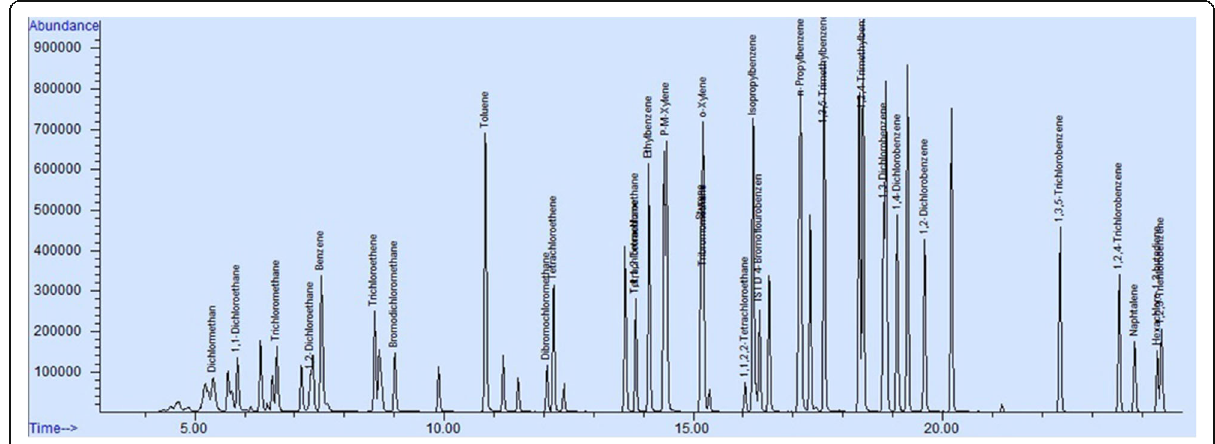
Fig. 3 Chromatogram of 5 μ g/L standard